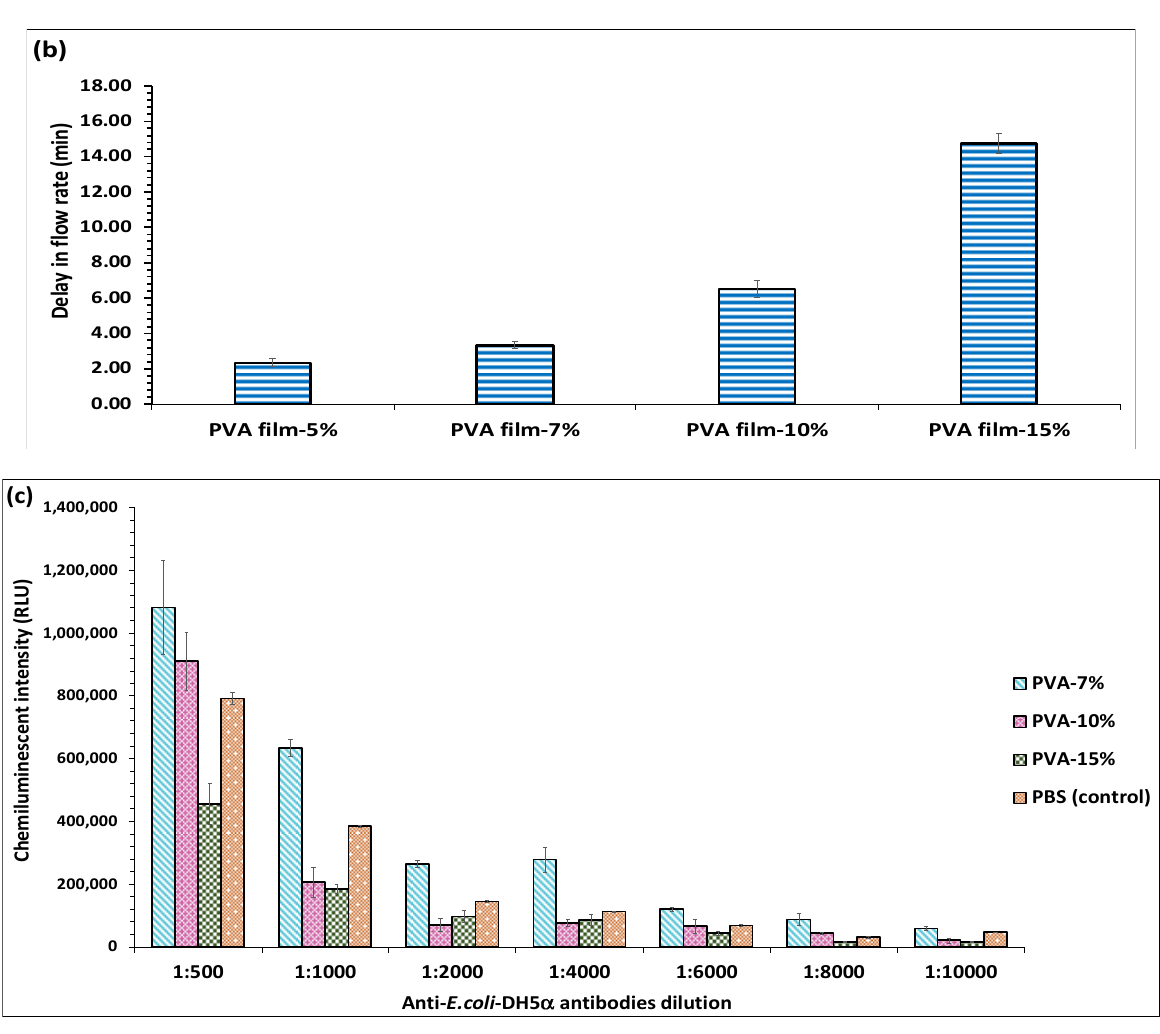
Figure 6. ( a ) Determination of optimal time required for the conjugation of capture antibody to E. coli ( b ) Effect of different concentrations of PVA films on the delay of sample flow rate ( c ) Effect of different concentrations of PVA on the activity of anti- E. coli antibody.